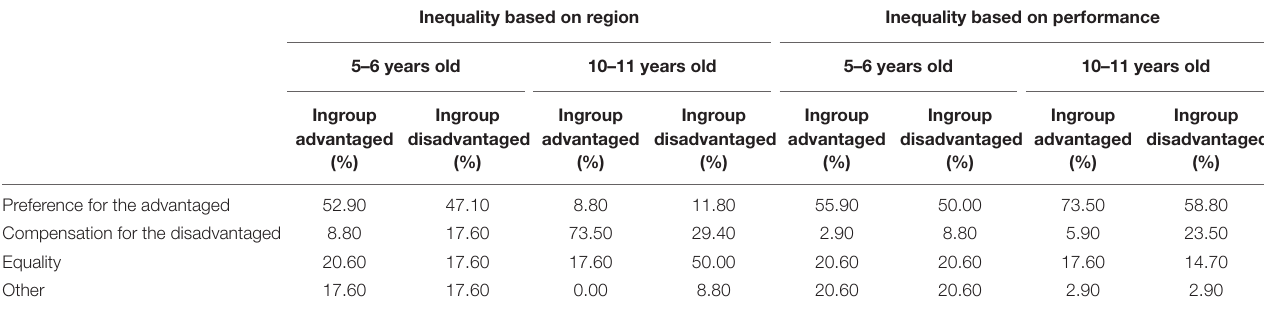
TABLE 2 | Children’s justifications for allocation in the context of inequality with different origins. Inequality based on